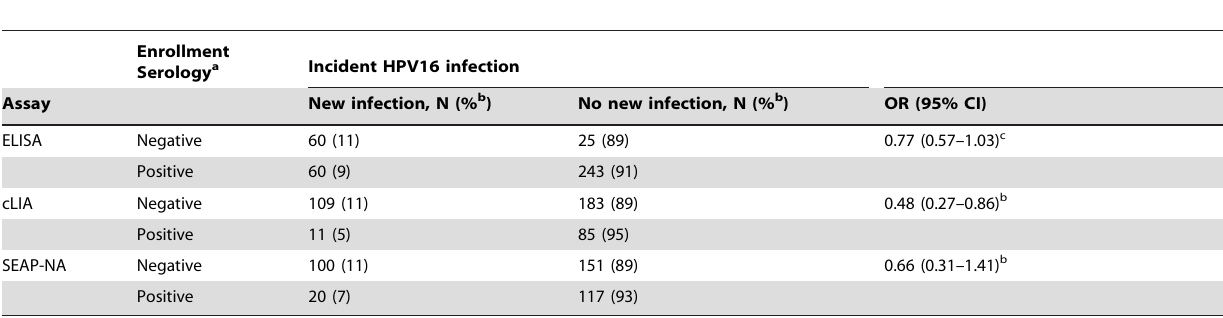
Table 2. Comparison of HPV16 serology assays at enrollment and protection against incident HPV16 DNA infections during four years of follow-up.